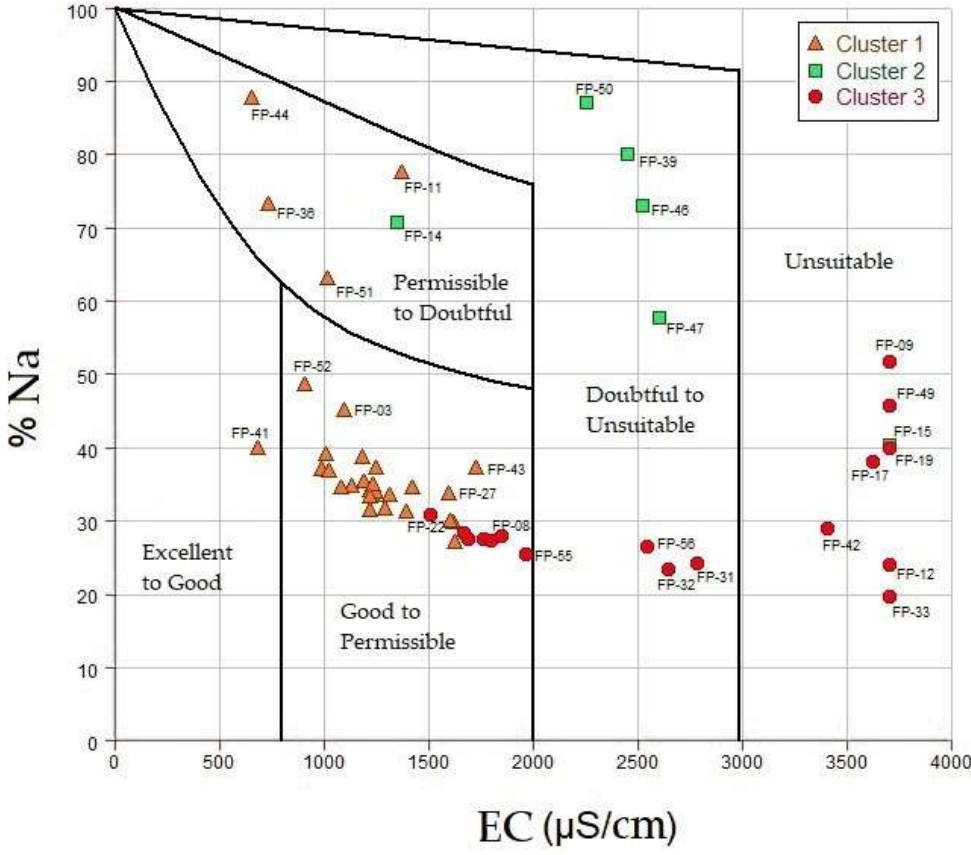
Figure 14. Classification of water for irrigation purposes.